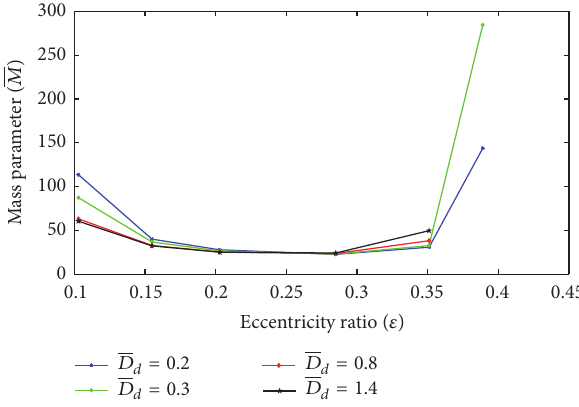
Figure 20: Effect of dam depth ratio on cross-coupled stiffness coefficient.